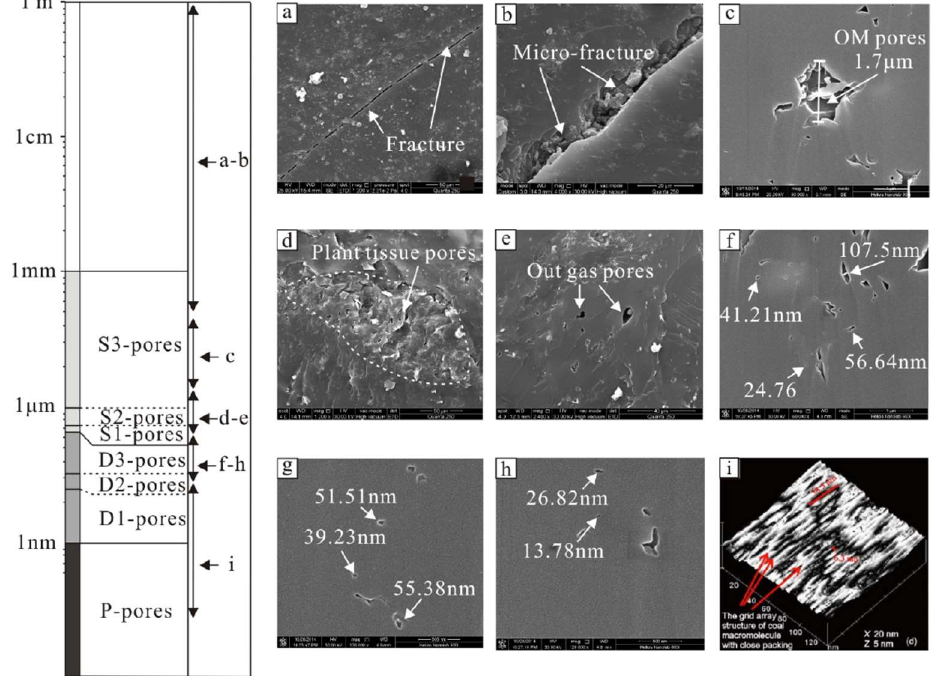
Figure 9. Pore types and morphological characteristics in the (a-i) of different pore size ranges, according to pore size classification. ((a-h), FE-SEM images; (i), AFM image.